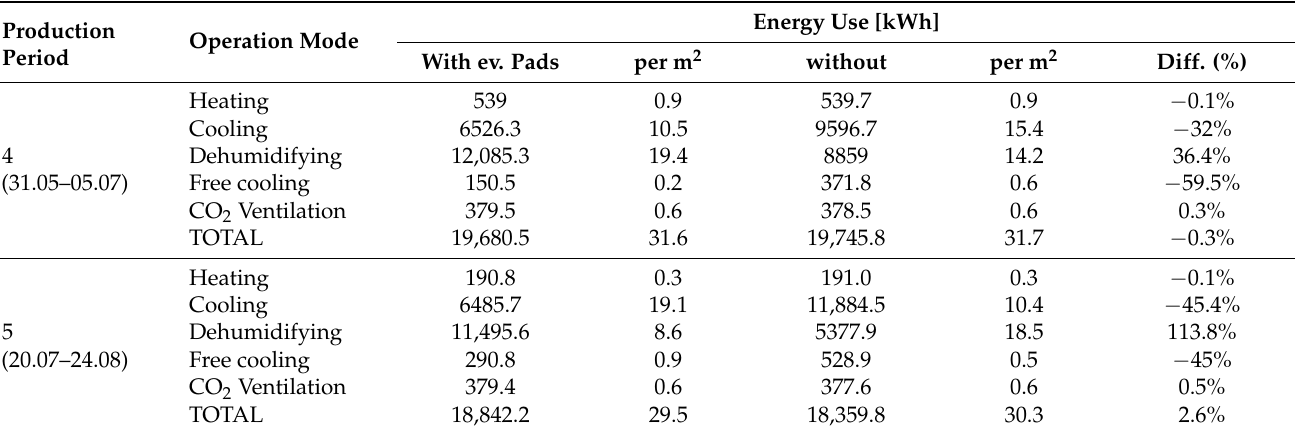
Table 8. The energy use of each operation mode for the warmest production periods when evaporative pads are also